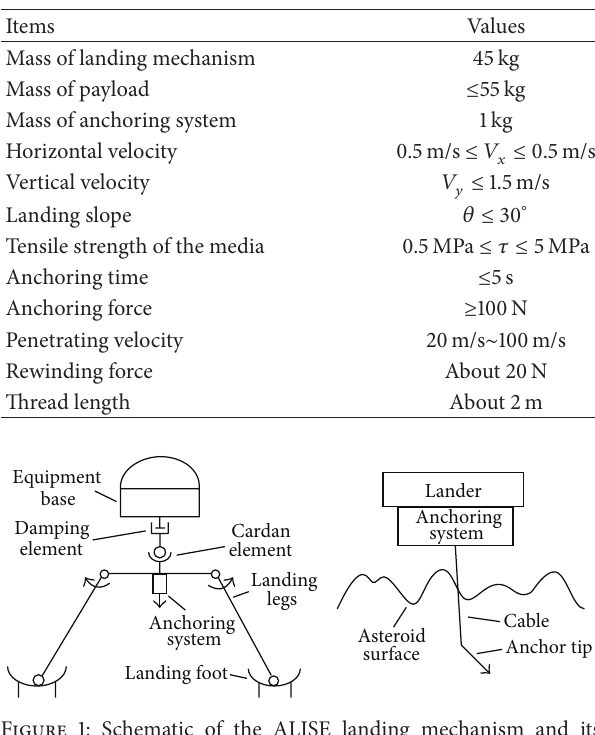
Figure 1: Schematic of the ALISE landing mechanism and its anchoring